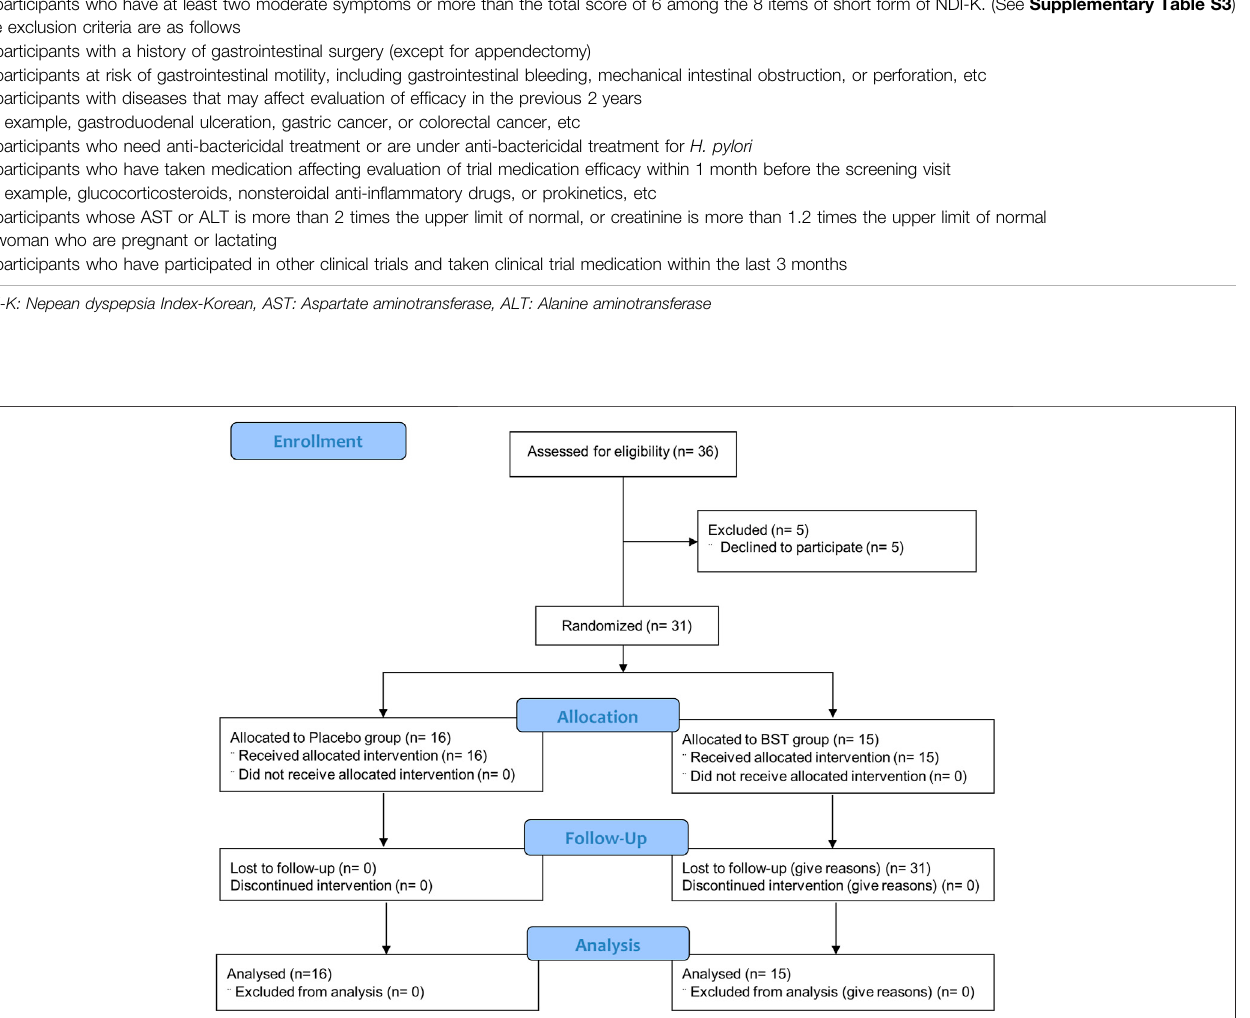
FIGURE 1 | Study fl ow